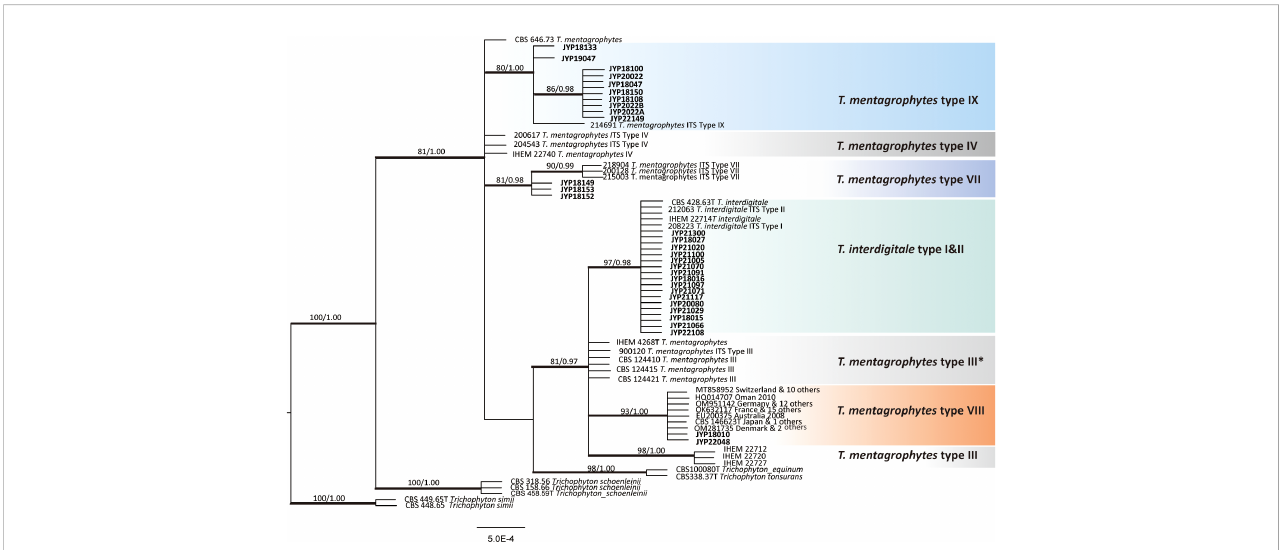
FIGURE 3 Phylogenetic tree constructed through Bayesian inference analyses based on ITS sequences showing relationships of eight genotype belonging to the T. mentagrophyte s/ T. interdigitale complex (TMTISC). Only support values exceeding bootstrap values of 70% and Bayesian posterior probabilities of 0.95, respectively, are shown. Ex-type isolates are designated by a superscript T. Trichophyton simi CBS 449.65 was used as the outgroup. Guizhou strains are highlighted in